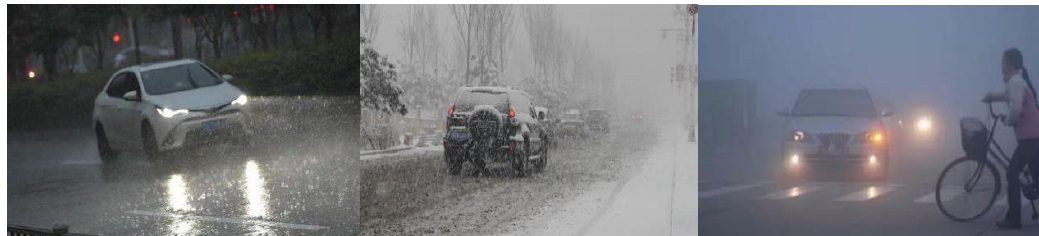
Figure 2. Traffic scene on rainy, snowy, and foggy days. Figure 2. Tra ffi c scene on rainy, snowy, and foggy